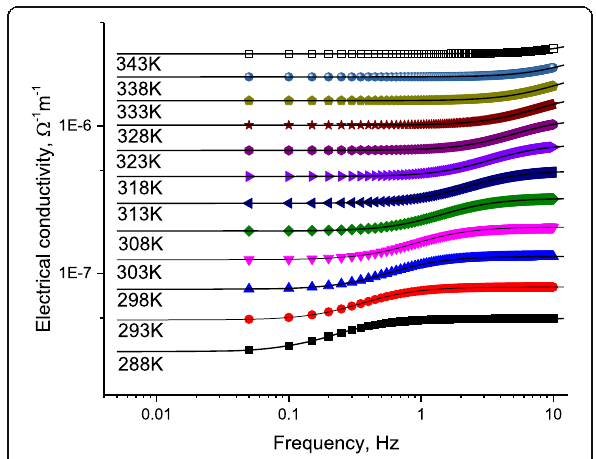
Fig. 15 Low frequency dependence of the AC-conductivity for DNA molecule and for different temperatures (H1). Lines represent calculated values after Eq. (12) with the data in Figs. 8 and 9. Symbols represent experimental values. One can see the effect of temperature on H1